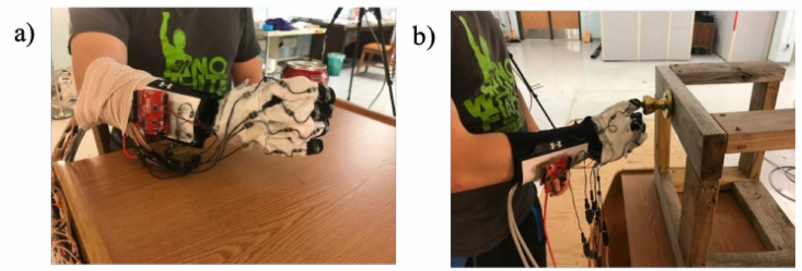
Figure 5. Force glove test setups for ( a ) can grasp and ( b ) key turn